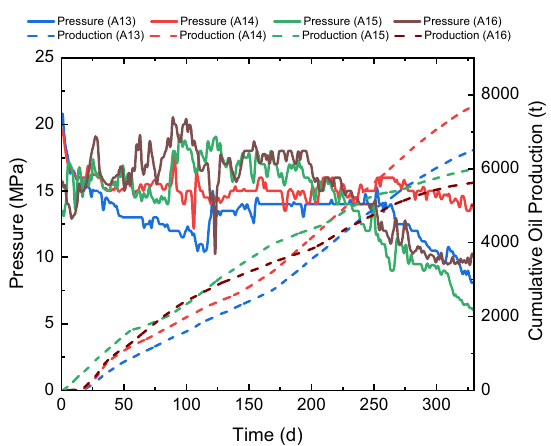
Figure 13. Production curves of comparison wells with different fracture spacings.